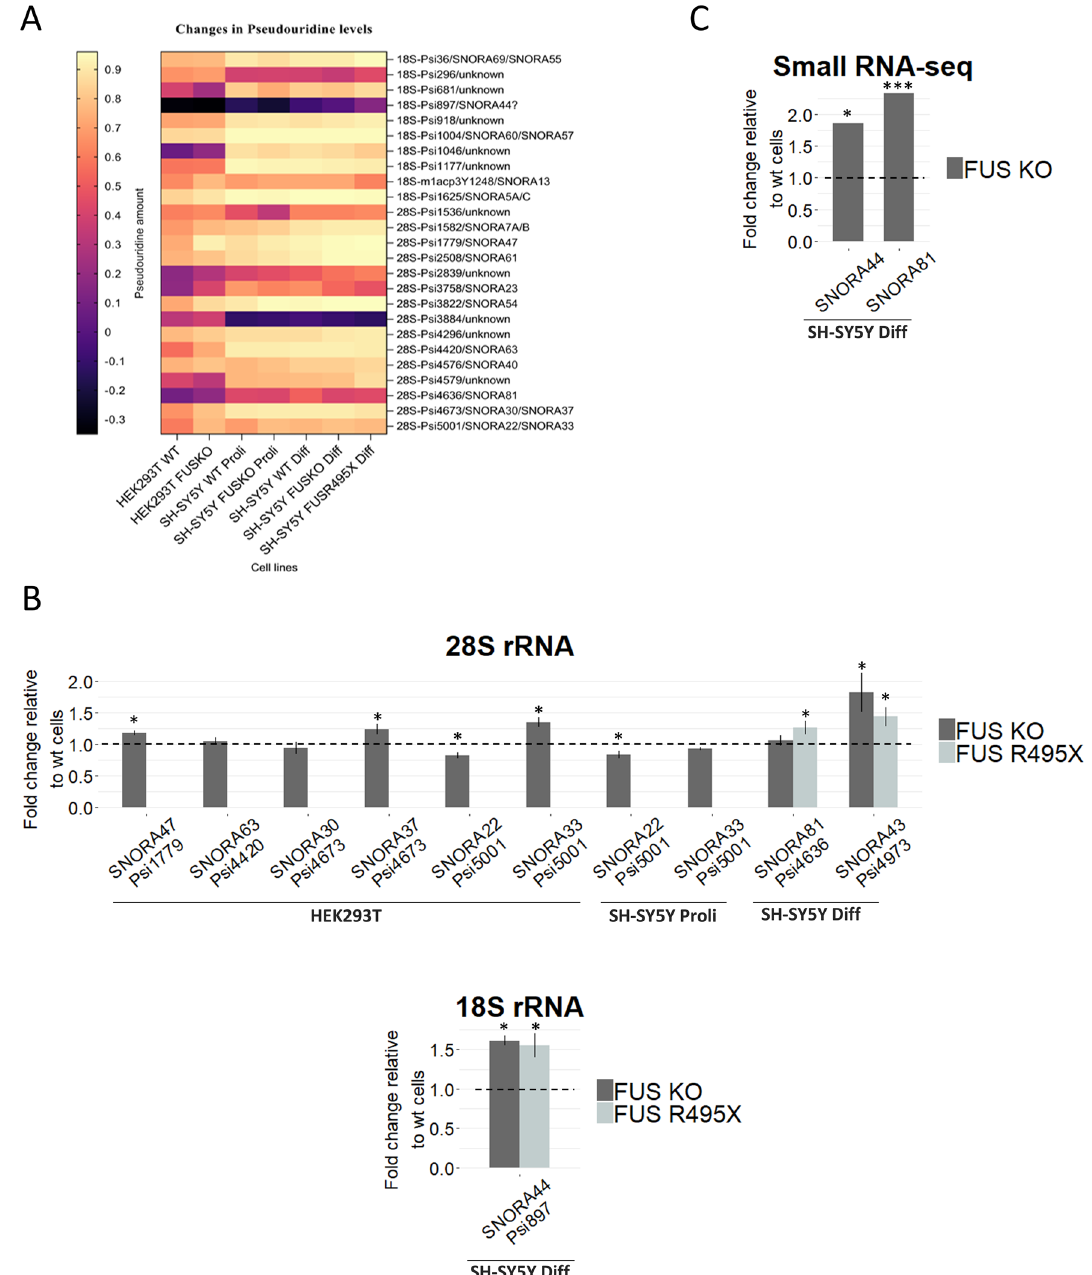
Figure 4. Differential heatmap for variations in pseudouridylation levels in all cells analyzed, representing the mean of three biological replicates from each cell line ( A ). Heatmap was generated using Graphpad Prism 8.4.2 (https:// www. graph pad. com/ scien tific- softw are/ prism/). Heatmap represents sites with at least a 10% (0.1) difference in pseudouridylation between cell types. RT-qPCR analysis of relative expression levels of selected box H/ACA snoRNAs that guide pseudouridylation of residues in 18S rRNA and 28S rRNA ( B ). The values represent the mean and error bars indicate the SD of three biological replicates from each cell line. HEK293T FUS KO cells, proliferating (Proli) SH-SY5Y FUS KO cells, differentiated (Diff) SH-SY5Y FUS KO cells, and SH-SY5Y FUS R495X cells were compared to WT cells, respectively. P values were calculated using Student’s t -test, and the statistical significance is defined as follows: * P ≤ 0.05. Small RNA-seq results for some of the differentially expressed H/ACA box snoRNAs identified by DEseq2 analysis in Diff SH-SY5Y FUS KO cells and presented as relative fold change as compared to WT cells ( C ). *Padj ≤ 0.05; ***Padj ≤